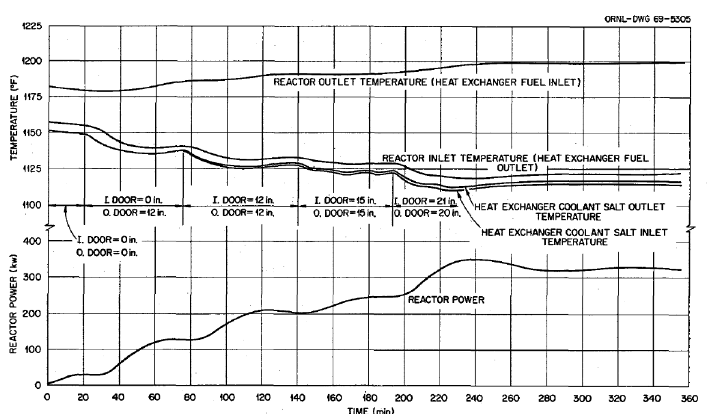
Figure 8. Salt temperature and power for the thermal-convection heat removal test